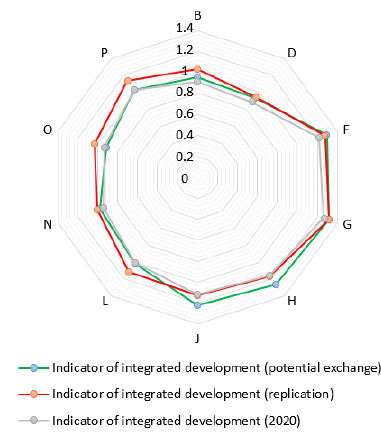
Table 7. Results of integrated enterprise development according to the potential exchange.